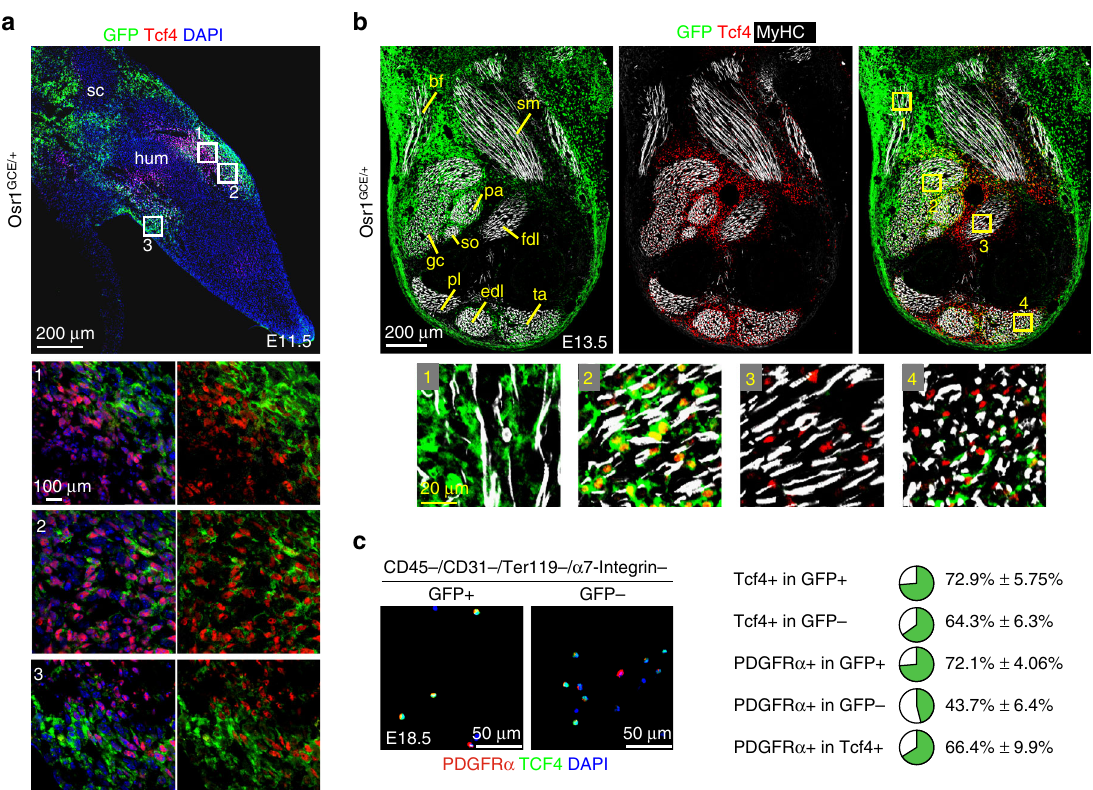
Fig. 2 Osr1 and Tcf4 identify distinct and common MCT cells. a , b Osr1 expression was assessed by immunolabelling for GFP on E11.5 and E13.5 Osr1 GCE/ + embryos. Boxed regions are shown in the numbered panels below and are magni fi cations of the area. a At E11.5 Osr1 is expressed in limb mesenchyme at the level of the humerus condensation overlapping with Tcf4. Tcf4 is expressed towards the centre and Osr1 towards the periphery of the limb. b At E13.5 Osr1 is expressed in limb mesenchyme in the periphery and encompassing the biceps femoris (bf), gastrocnemius (gc), soleus (so), plantaris (pa), semimembranosus (sm), peroneus longus (pl), extensor digitorum longus (edl) and tibialis anterior (ta) muscles. Tcf4 is expressed in central areas of the limb, where it is exclusive in the fl exor digitorum longus (fdl) muscle, and within and surrounding the edl and ta muscles. c E18.5 limb muscle interstitial cells were FACS-isolated as indicated and separated into Osr1 -expressing and Osr1 -negative (GFP + and GFP − ) populations. Cytospun cells were labelled for Tcf4 and PDGFR α . Quanti fi cation showing the percentages of PDGFR α + and Tcf4 + cells in GFP + or GFP − populations is shown below. Percentage of PDGFR α cells in all Tcf4 cells was counted in both GFP + and GFP − populations ( n = 3). Values represent mean ± s.e.m ( n = 3). N-numbers